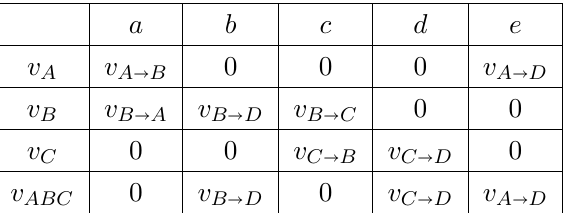
Table 1 . Partitioning of the 4 maximizer (cid:13)ows (indicated in the left column) into thread bundles con(cid:12)ned to the 5 bulk regions (indicated in the top row). Each row corresponds to an equation delineating this partition, e.g. the (cid:12)rst row gives v are supported entirely within the regions a and e , respectively, and similarly for the other rows.